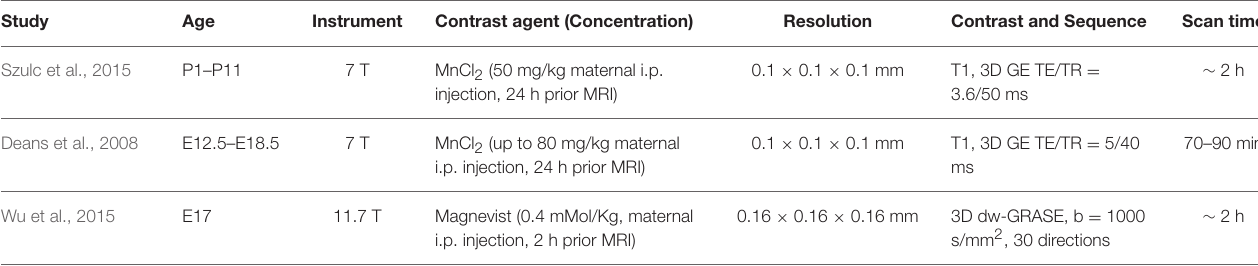
TABLE 2 | Imaging parameters of selected reports on in vivo MRI of the embryonic and neonatal mouse brain. Study Age Instrument Contrast agent (Concentration) Resolution Contrast and Sequence Scan